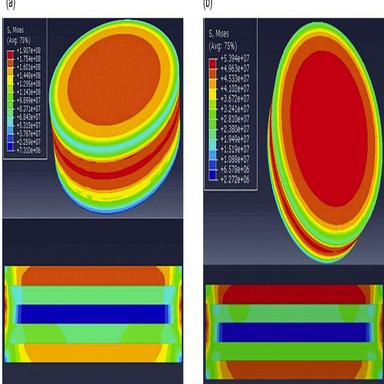
SEM of interface of TY-6-1. (a)Interface of Layer1-Layer2, (b)Interface of Layer2-Layer3, (c)Interface of Layer3-Layer4, (d)Interface of Layer4-Layer5.